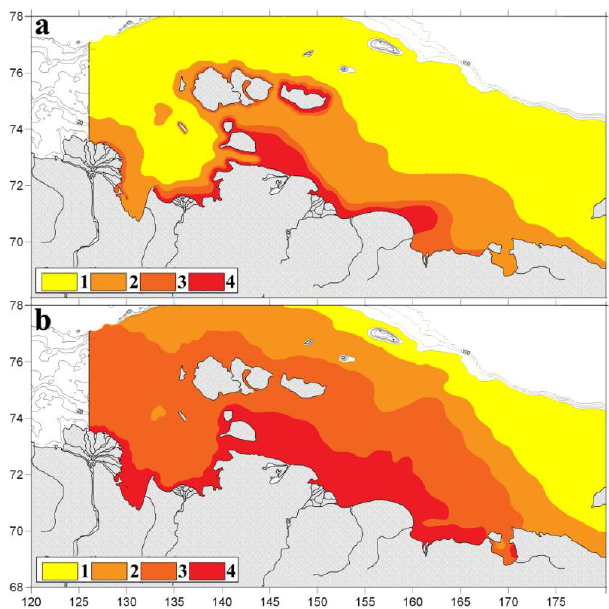
Fig. 4. The secondary role of the Lena River and the dominat- ing role of coastal erosion in ESAS sedimentation is illustrated by the surface distribution of: (a) suspended particular materials (PM, mgl − 1 ) : (1) < 2, (2) 2.1–13, (3) 13.1–24, (4) > 24; (b) CTOM of POC (%) (1) < 25, (2) 25–50, (3) 51–75, (4) >